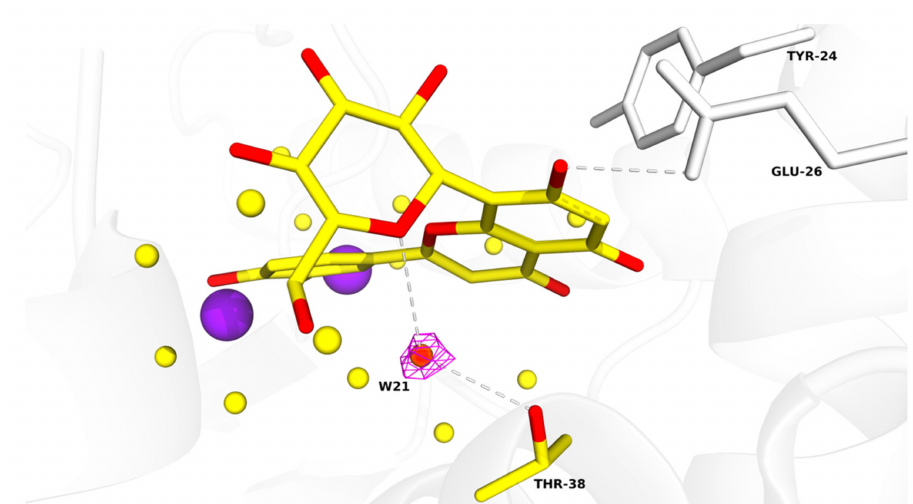
Figure 5. Closeup view of the active site pocket of I38T PA-Nter. Metal ions are shown as purple-blue spheres. Ligand and amino acid residues are shown in stick representation, where red represents oxygen atoms. The hydrogen bonds between the ligand and the Glu-26 side chain and between the ligand, W21, and the Thr-38 side chain are depicted as grey dashes. Water molecules are shown as yellow spheres, except for W21 which is shown as a red sphere with its 2Fo–Fc electron density map in magenta mesh contoured at 1.5 σ